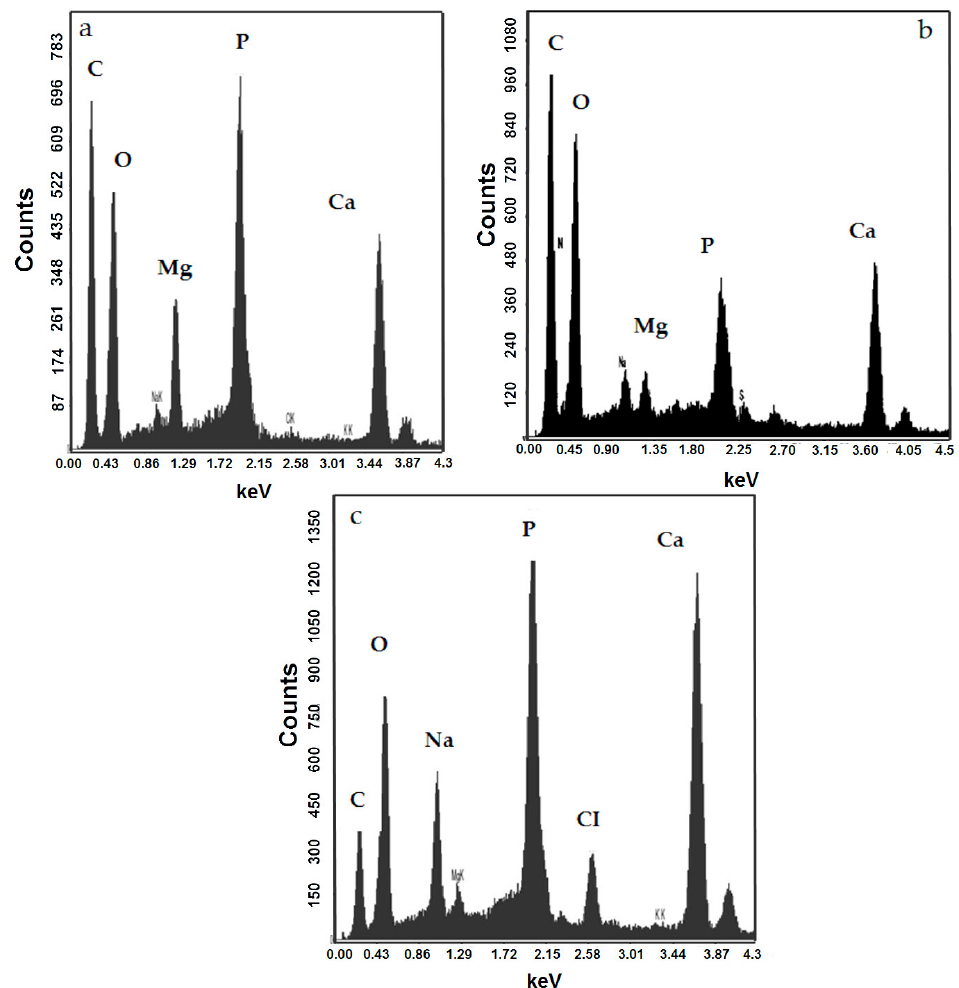
Figure 7. Energy dispersive (EDX) spectra of mineralized cells and nanoglobules indicated in Figure 6. ( a ) EDX spectra of g in Figure 6b; ( b ) EDX spectra of h in Figure 6d; ( c ) EDX spectra of i in Figure 6f.